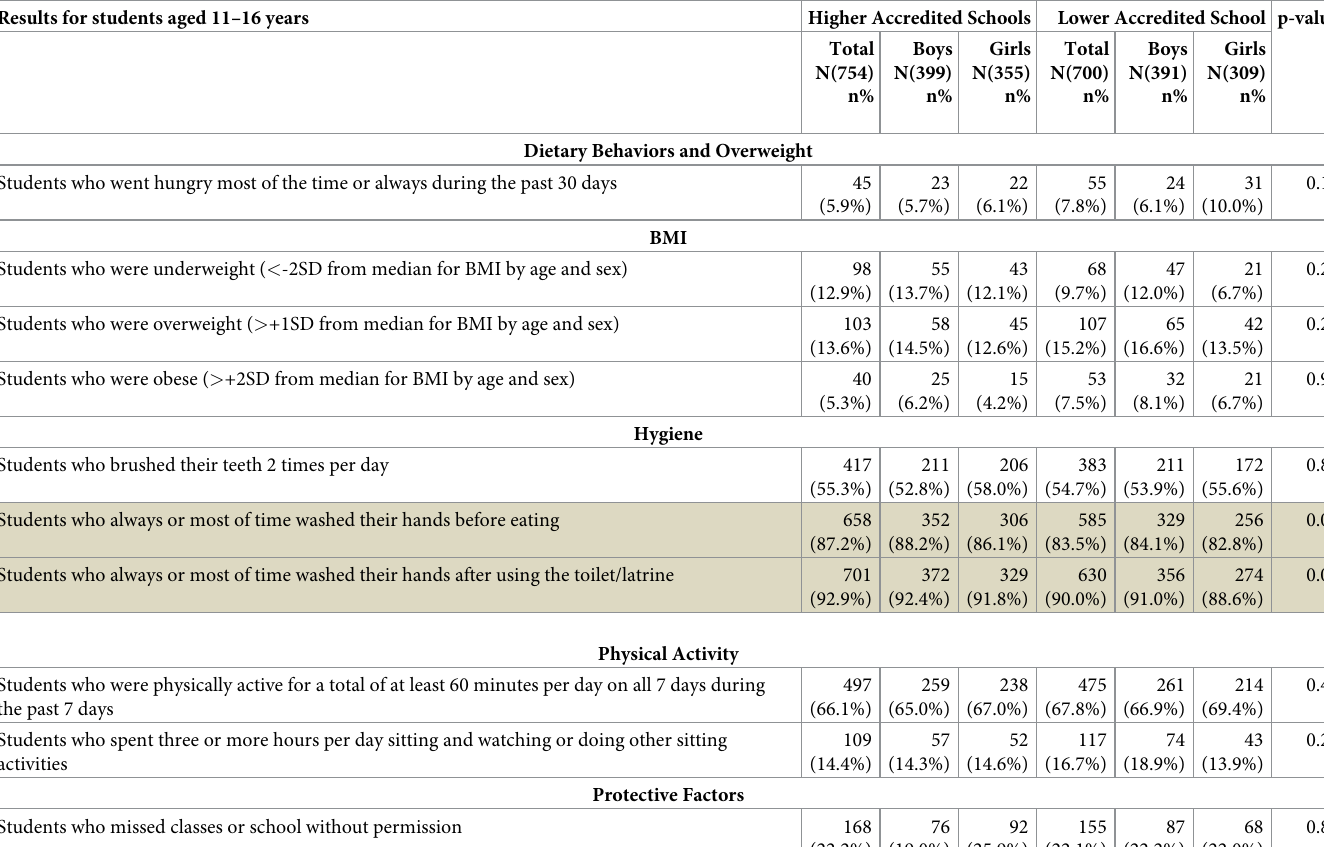
Table 4. Comparison of diet, physical activity and protective factors among school children in higher and lower accreditation schools in